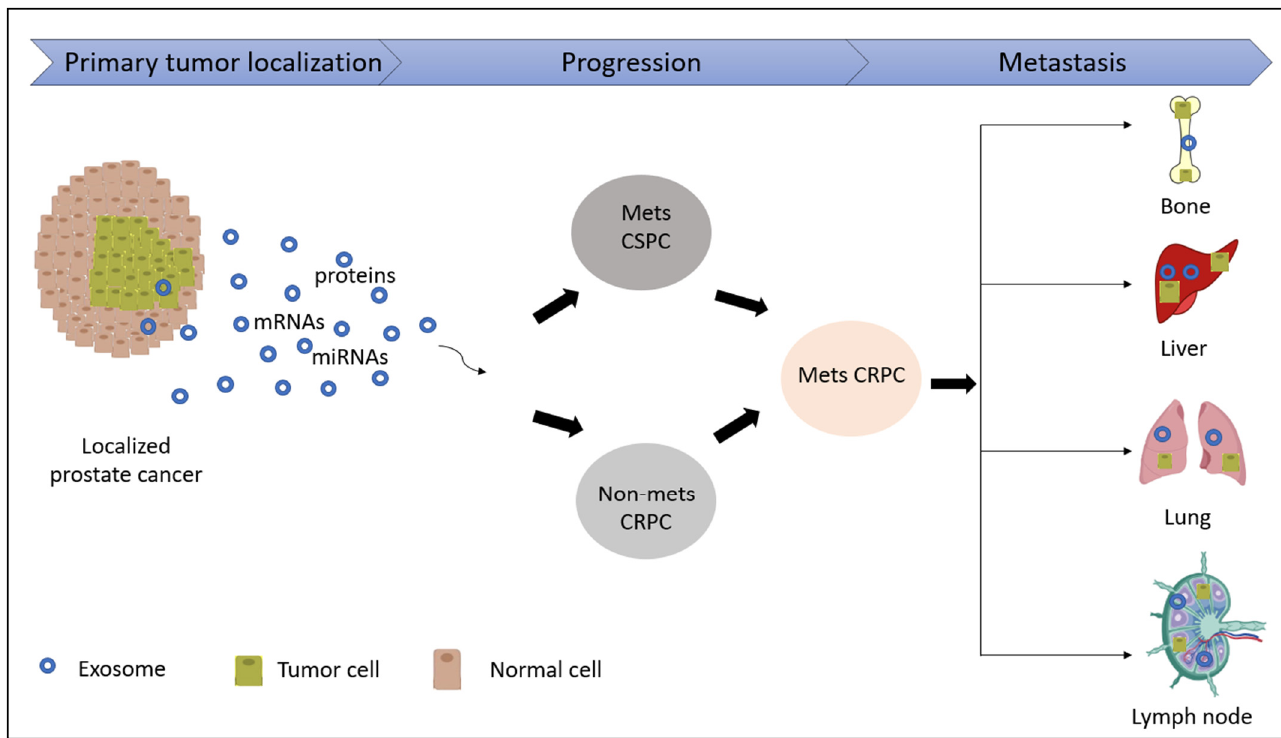
Figure 2. Schematic illustrating potential role of exosomes in prostate cancer progression. The release of tumor-derived exosomes enhances crosstalk across cells, leading to the progression of a localized PCa into either a metastatic Castration- Sensitive PCa (Mets CSPC) or a non-metastatic Castration-Resistant PCa (Non-mets CRPC). This ultimately leads to the advanced form of the disease; metastatic Castration-Resistant PCa (mCRPC) which can metastasize into various organs of the body such as bone, liver, lungs and lymph nodes.